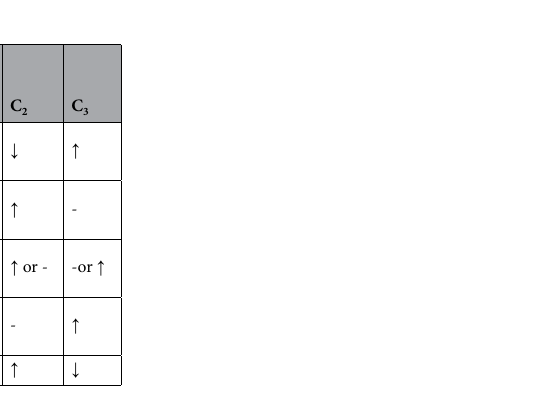
Table. 1. Switching sequence of 5L-QBI topology. *D-Diode, P-Pulse, ↑ -Charging ↓ -discharging, P ON/OFF - Pulse ON